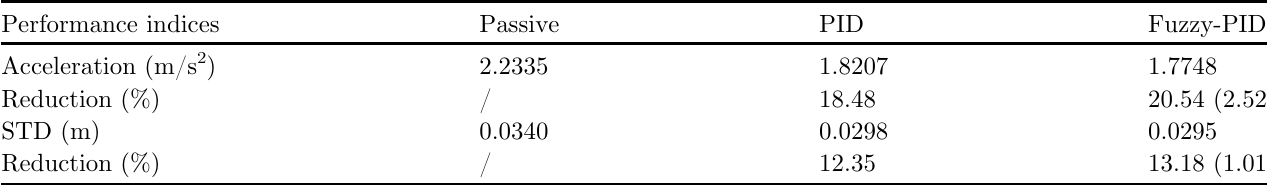
Table 7. Peak-to-peak values under random road pro fi